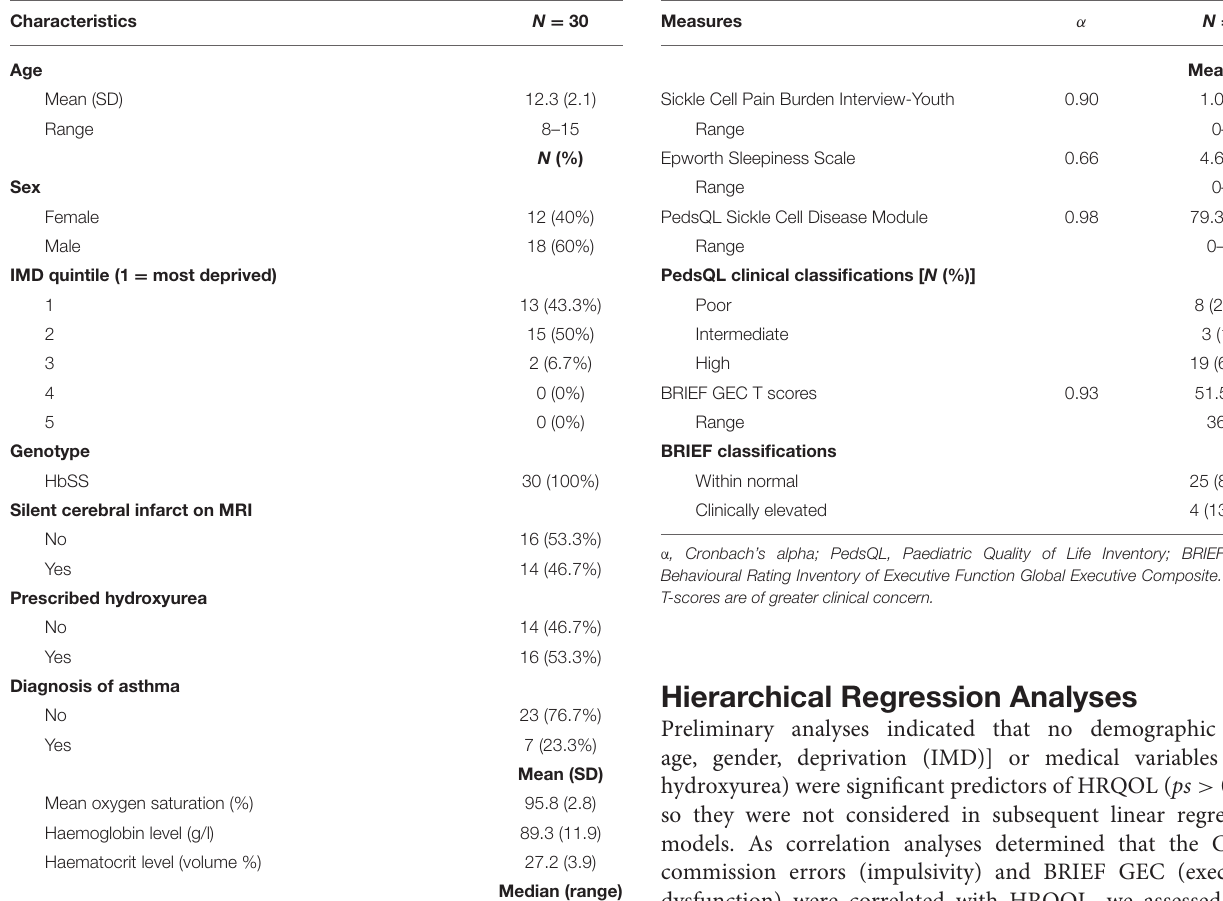
TABLE 2 | Patient-reported outcomes for POMS2b paediatric participants at baseline before